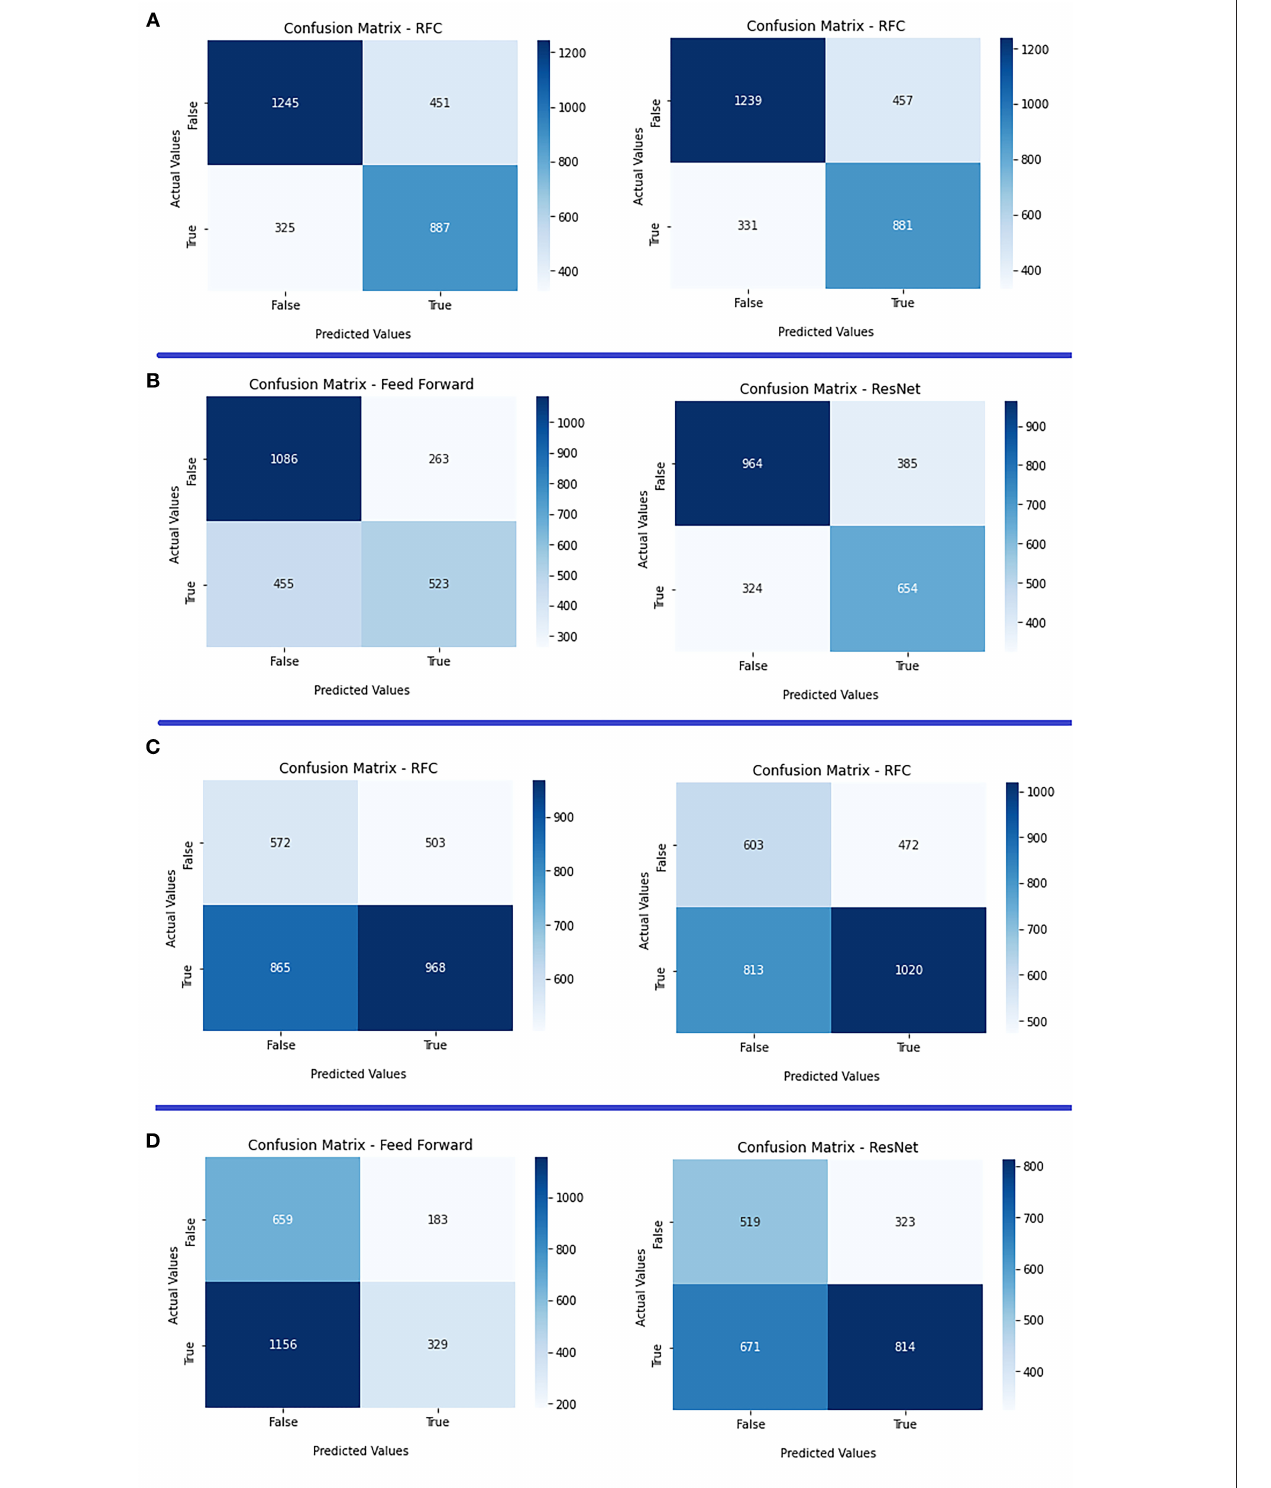
Frontiers in Neurology |